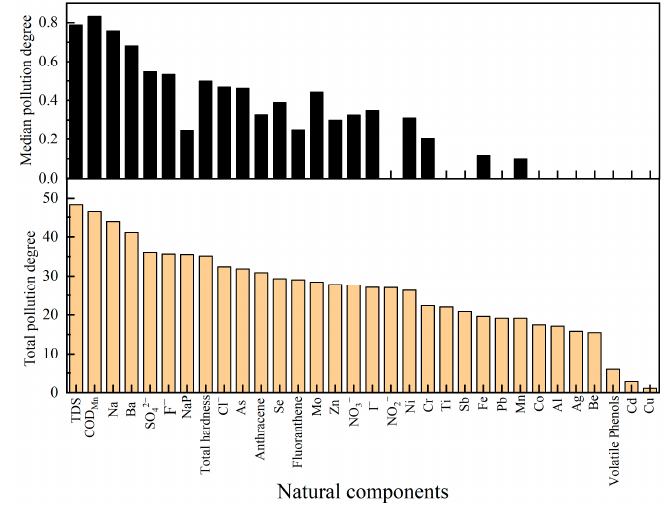
Figure 6. The pollution degree of natural